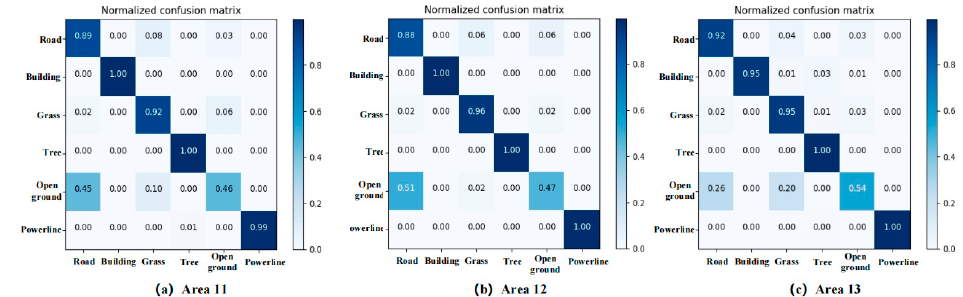
Figure 8. The calculated confusion matrices for three test areas.